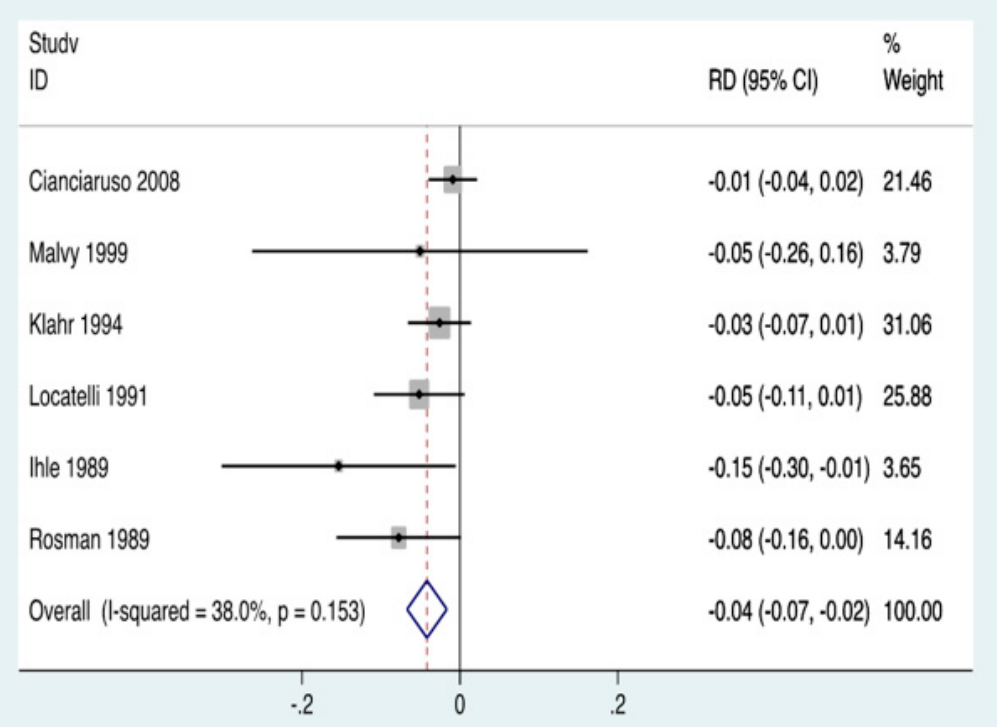
Figure 2. Meta-analysis of the randomized controlled trials with low protein diet suggesting efficacy of diet in lowering the risk of kidney failure. This meta-analysis includes six (out of 16) randomized control trials of low protein diet (adapted from Rhee et al., J Cachexia Sarcopenia Muscle 2018) [28].